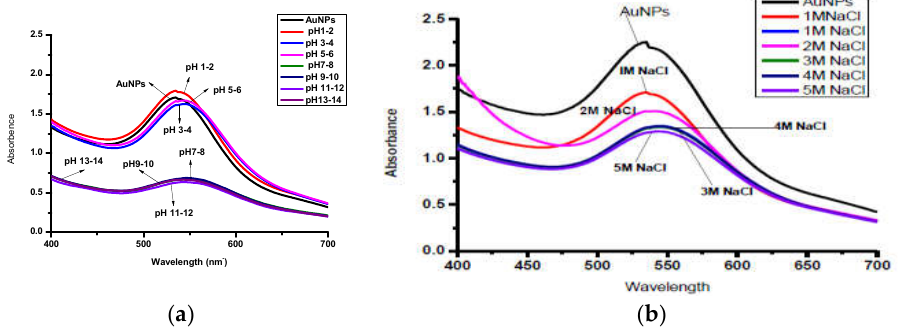
Figure 6. ( a ) Effect of different pH on AuNPs functionalized with crude flavonoids extract of Mi – cromeria biflora ; ( b ) effect of various concentrations (1–5 M) on stability of AuNPs.